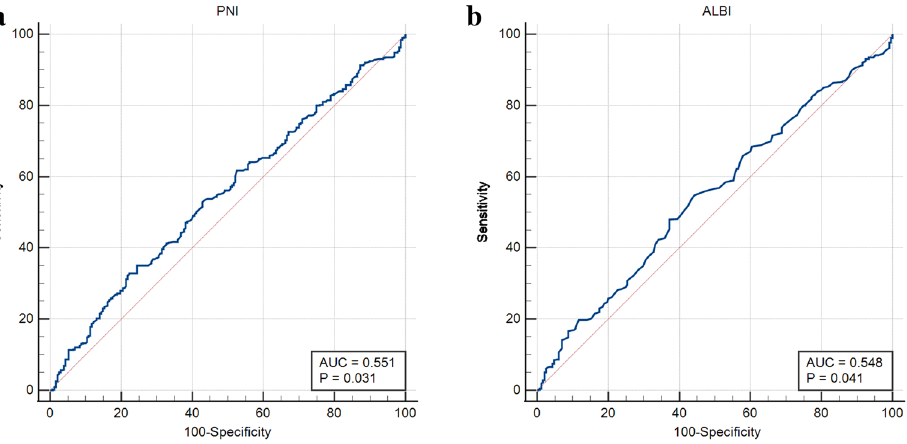
Figure 1. ROC curve for determination of the cut-off value of PNI (a) and ALBI (b) for predicting 5-year